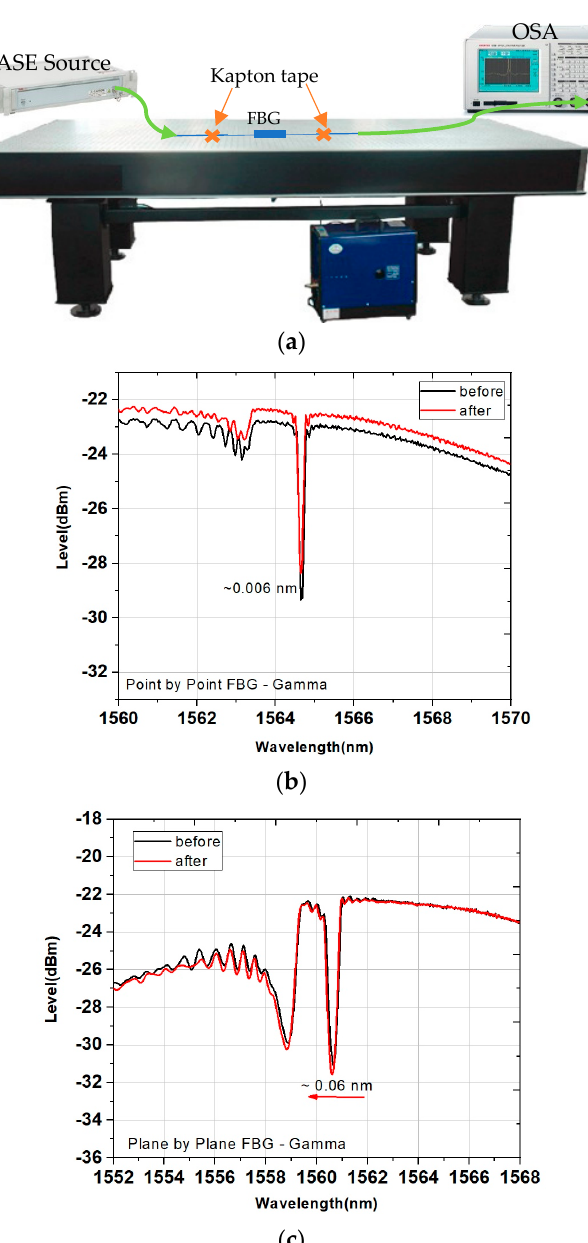
Figure 4. ( a ) Experimental schematic diagram of the FBG transmission measurements. Transmission spectra of the FBG before and after the exposure to γ -radiation ( b ) for the PbP -FBG and ( c ) for the PlbPl